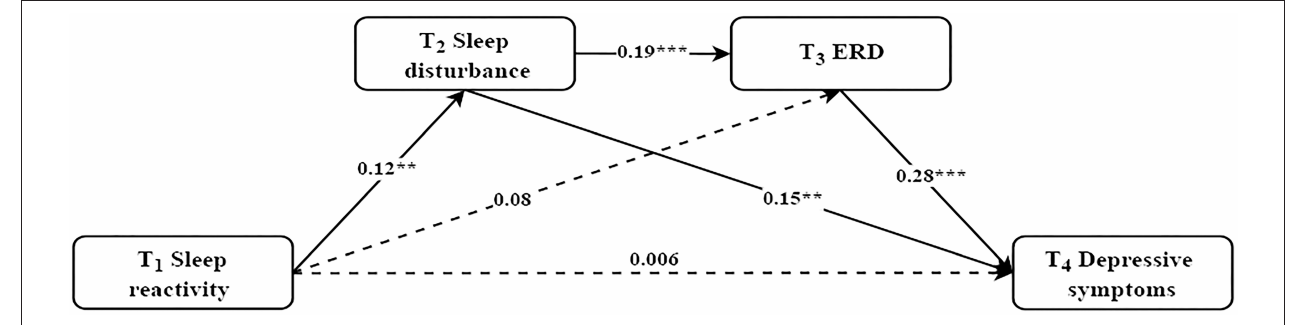
FIGURE 2 | The mediating effect of sleep disturbance and ERD in the relationship between sleep reactivity and depressive symptoms. Controlled for current alcohol use, parents’ marital quality, sleep disturbance at T 1 , ERD at T 1 , and depressive symptoms at T 1 . Standardized coefficients are reported; Dashed line indicates a non-significant coefficient; ** p < 0.01, *** p <